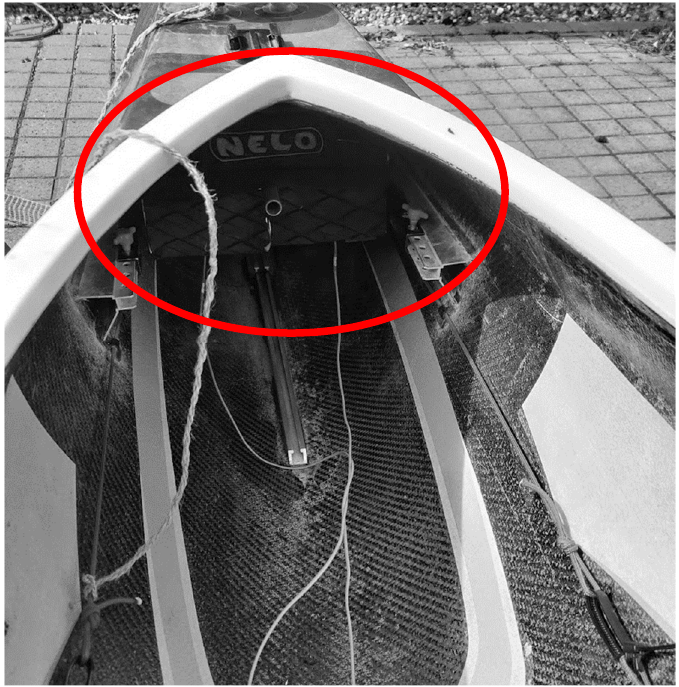
Figure 1. A view of the footrest mounted in a Nelo Cinco kayak. The custom-made footrest fits well in the kayak. It can be seen in the red circle.